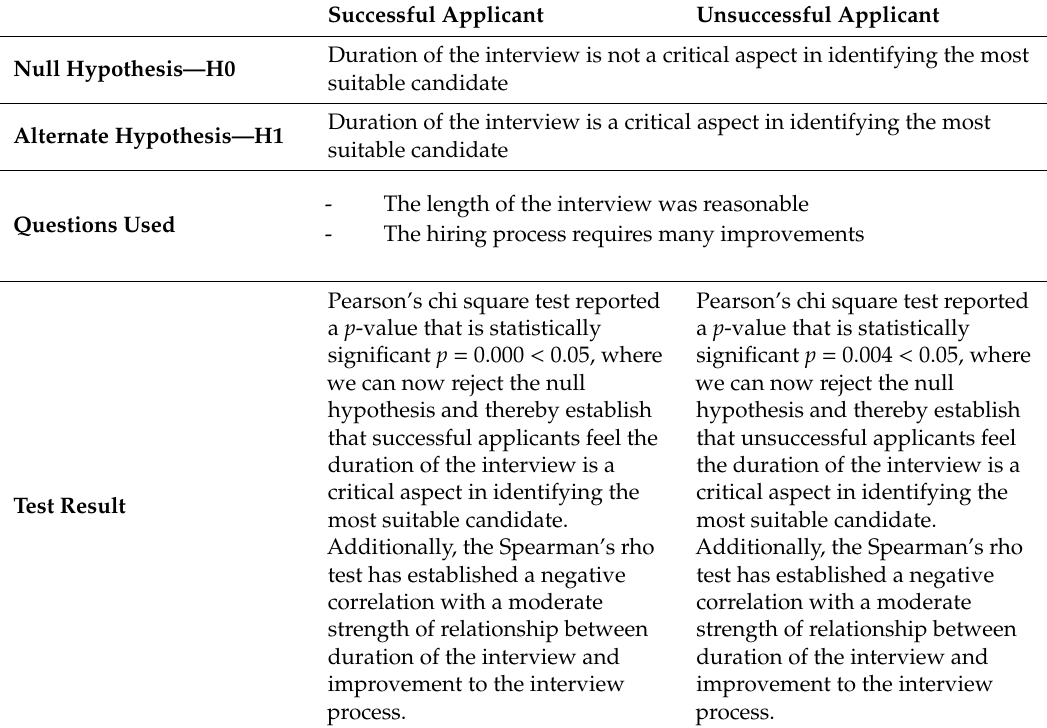
Table 8. Applicant Perspective Hypothesis 6—Duration of the